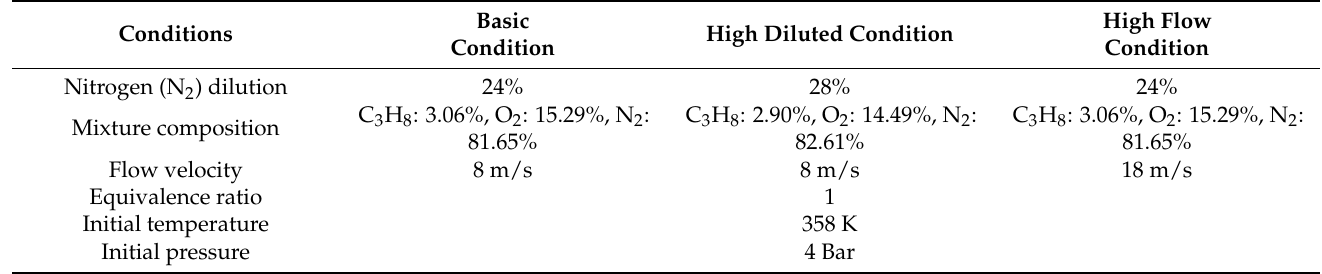
Table 2. Summary of experimental